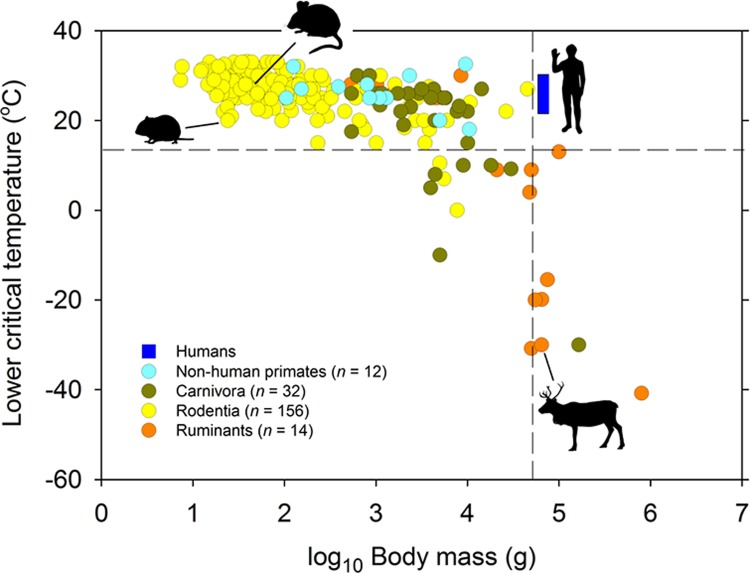
Relationship between Tlc (°C) and body mass (g) in mammals.The Tlc is defined as the ambient temperature below which the rate of metabolic heat production must be increased in order to maintain homeothermy. Of all species with Tlc above the global mean surface temperature (14°C, horizontal dashed line; [11]), humans (Tlc range from 23 to 33°C; [16,17]) are the most massive, and of all species with a body mass above 50 kg (vertical dashed line), humans have the highest Tlc. For clarity, the figure includes only data for a limited number of taxa (humans, Carnivora, nonhuman primates, Rodentia, ruminants). However, the shape of the relationship between body mass and Tlc does not change when data for other groups are included (Chiroptera, Cingulata, Dasyuromorphia, Diprotodontia, Erinaceomorpha, Eulipotyphla, Hyracoidea, Lagomorpha, Macroscelidea, Monotremata, Peramelemorphia, and Soricomorpha). Species data indicated by silhouettes are, clockwise from the left, for voles (M. arvalis), mice (M. musculus), humans, and reindeer (R. tarandus). Data from [12,13,18,19]. Tlc, lower critical temperature.